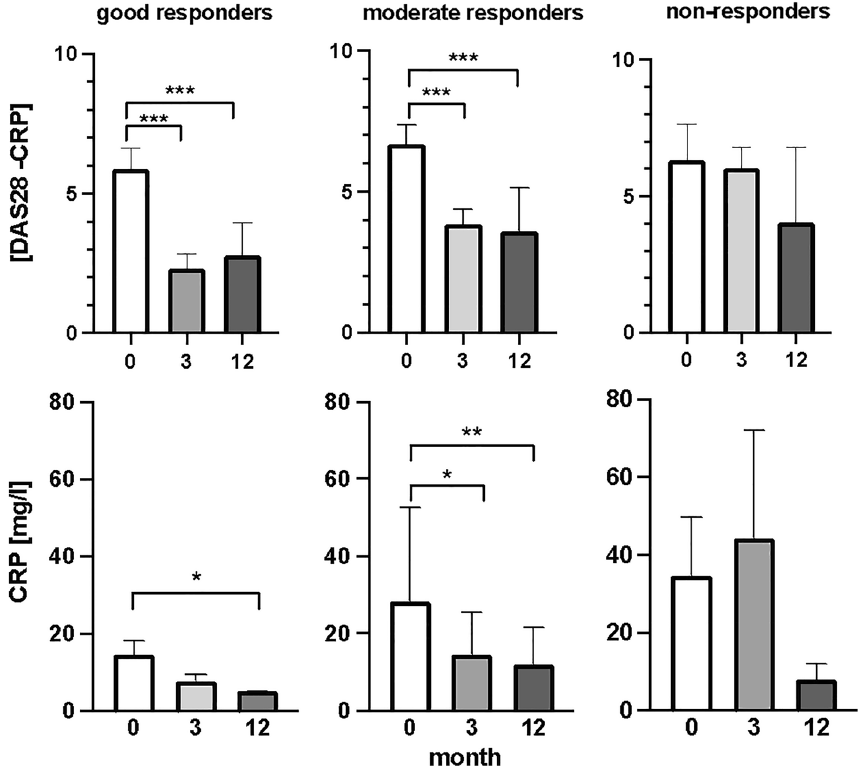
Figure 2. Clinical status of patients with rheumatoid arthritis divided into groups based on their response to biological treatment (good, moderate, and non-responders). Before initiation of bDMARDs and 3 and 12 months during ongoing treatment ( p < 0.05 = *, p < 0.01 = **, p < 0.001 = ***).